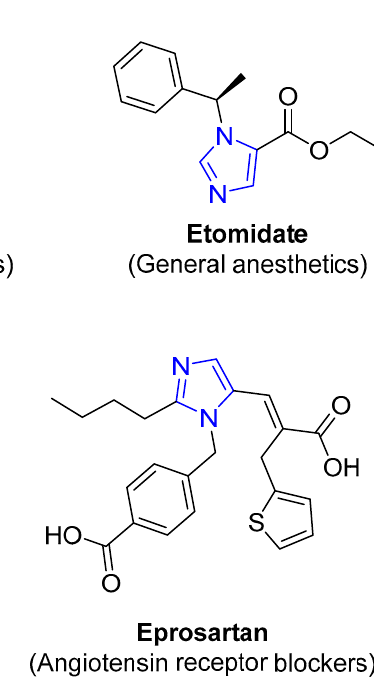
Figure 6. Drugs containing an imidazole ring.